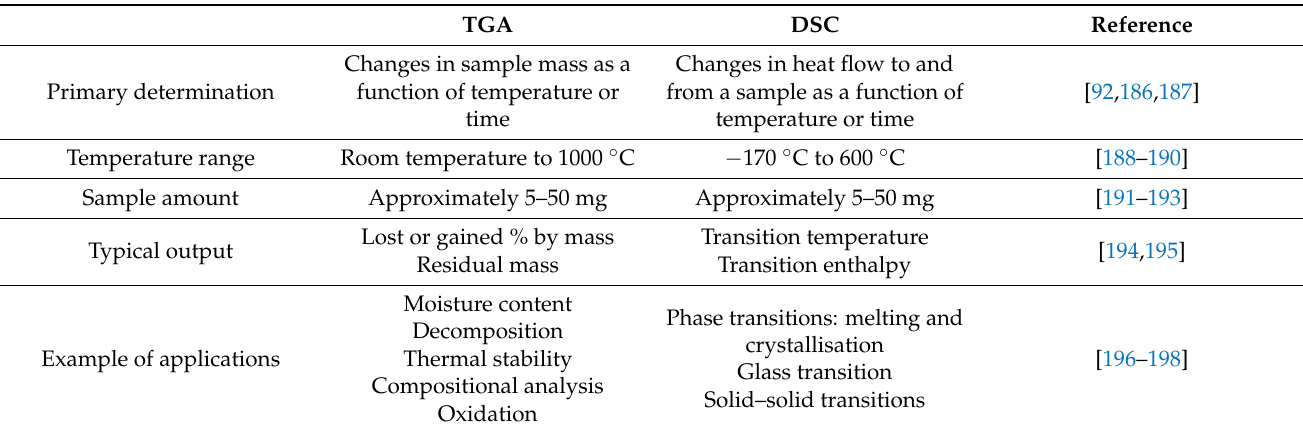
Table 4. Comparison of TGA and DSC.